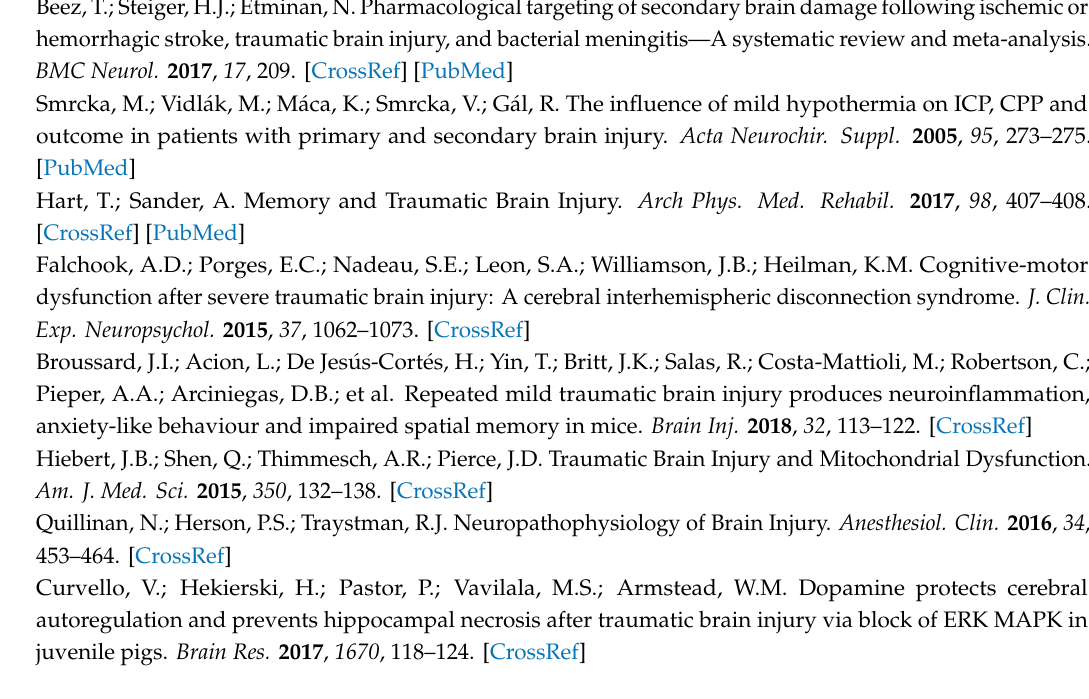
Figure S1: Determination of the cytotoxic e ff ect of cerebrospinal fluid control (CSF-N) and injured (CSF-TBI) rats, Figure S2: Determination of half maximal inhibitory concentration (IC50) of PQ-29 for viability of rat C6 glioma cells, Figure S3: General view in transmitted light of C6 cells after culturing them for 24 hours in the presence of CSF control rats (CSF N ), injured rats (CSF TBI ) and in the presence of PQ-29 at the concentrations indicated in the